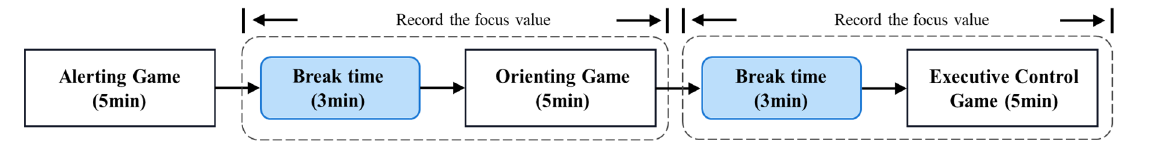
Figure 15. Recording time of Focus value measurement.